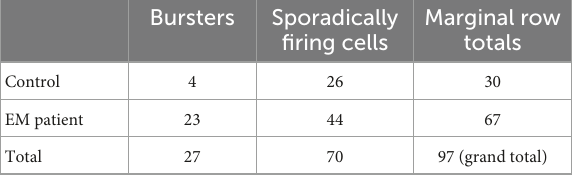
TABLE 1 Number of bursting versus sporadically firing cells in erythromelalgia (EM) patient versus control human induced pluripotent stem cell-derived sensory neurons